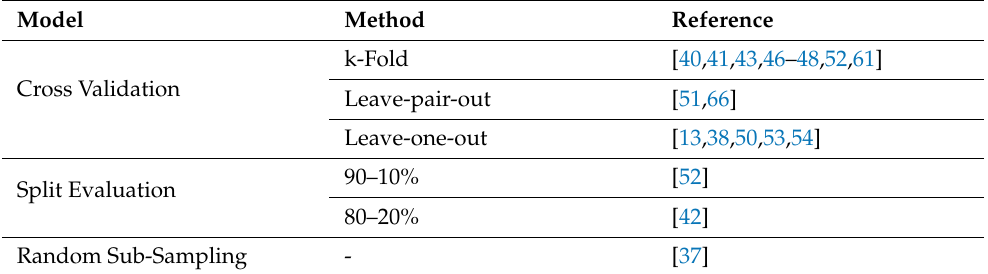
Table 6. Evaluation models for classification models.